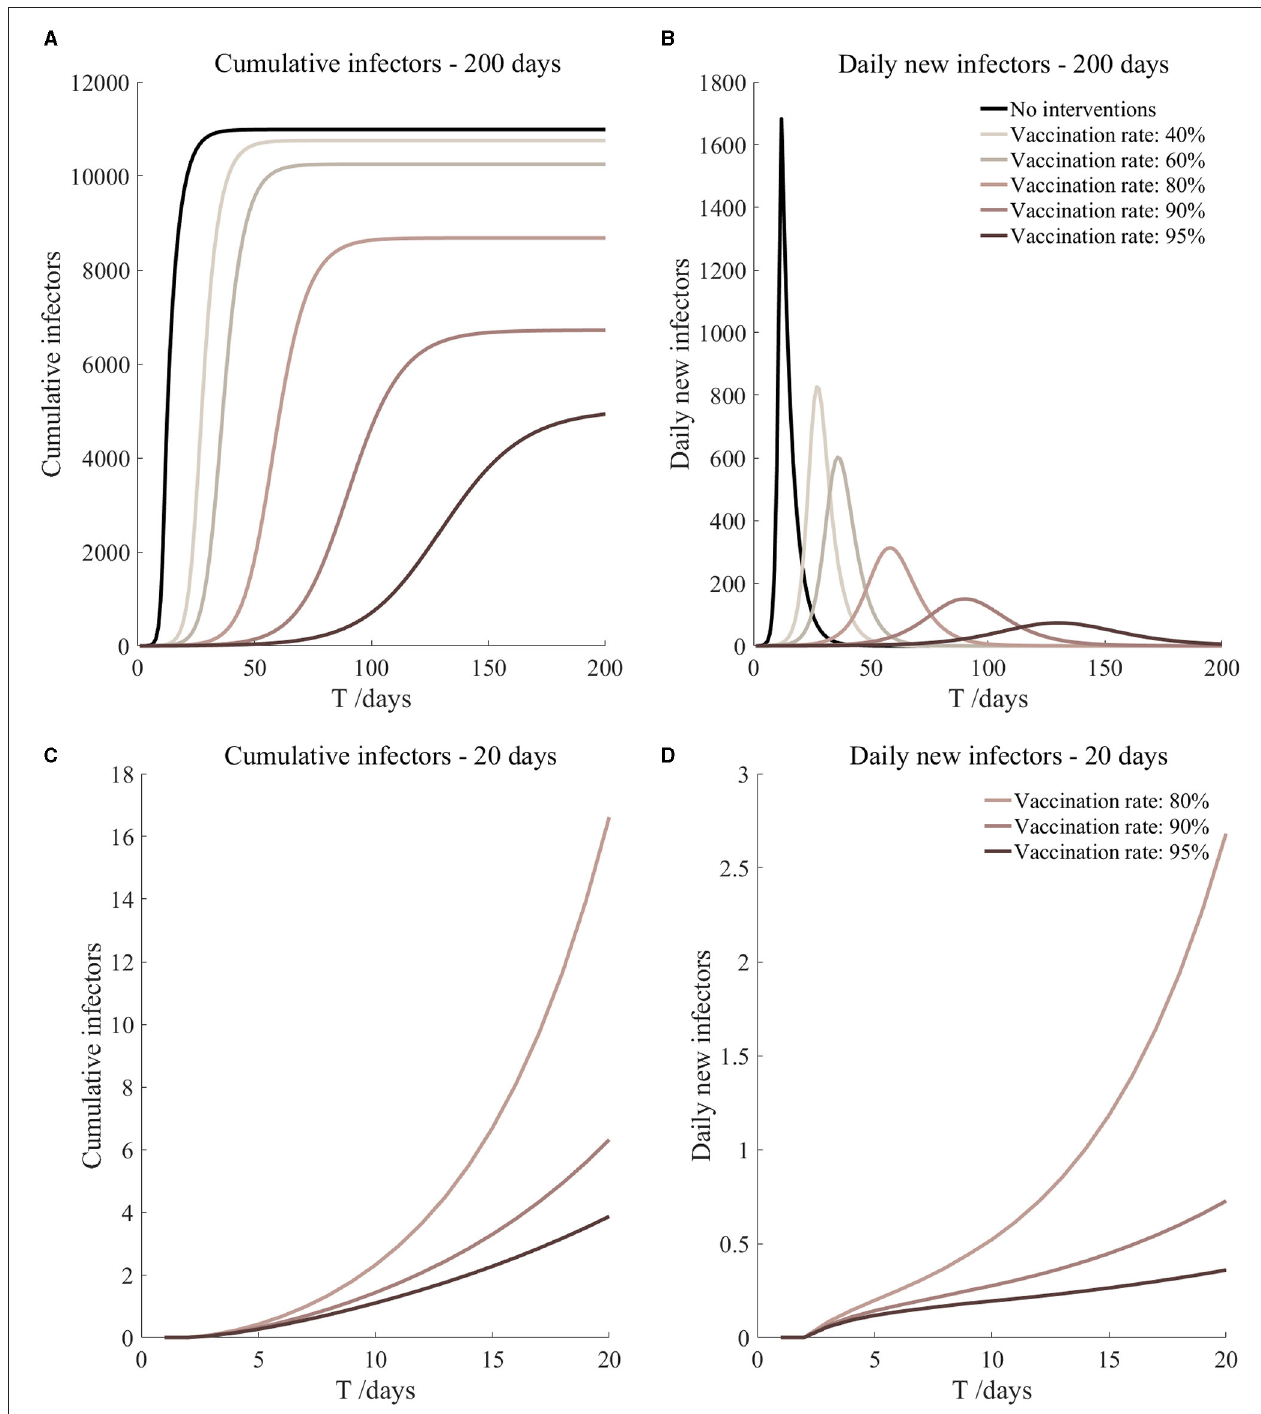
FIGURE 6 | Vaccinated but not quarantined. Assume pre-flight screening can identify 40% of asymptomatic infectors.